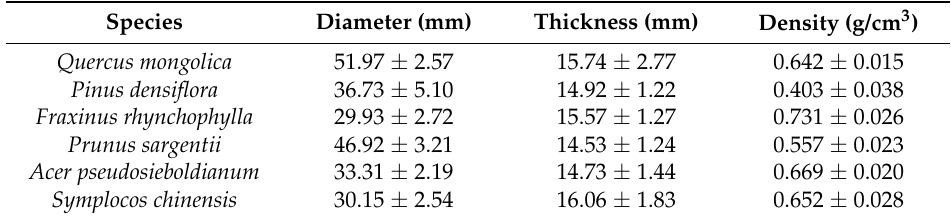
Table 1. Morphological properties of branch wood disk samples for six tree species. Values are means ( n = 5) ± SD. Species Diameter